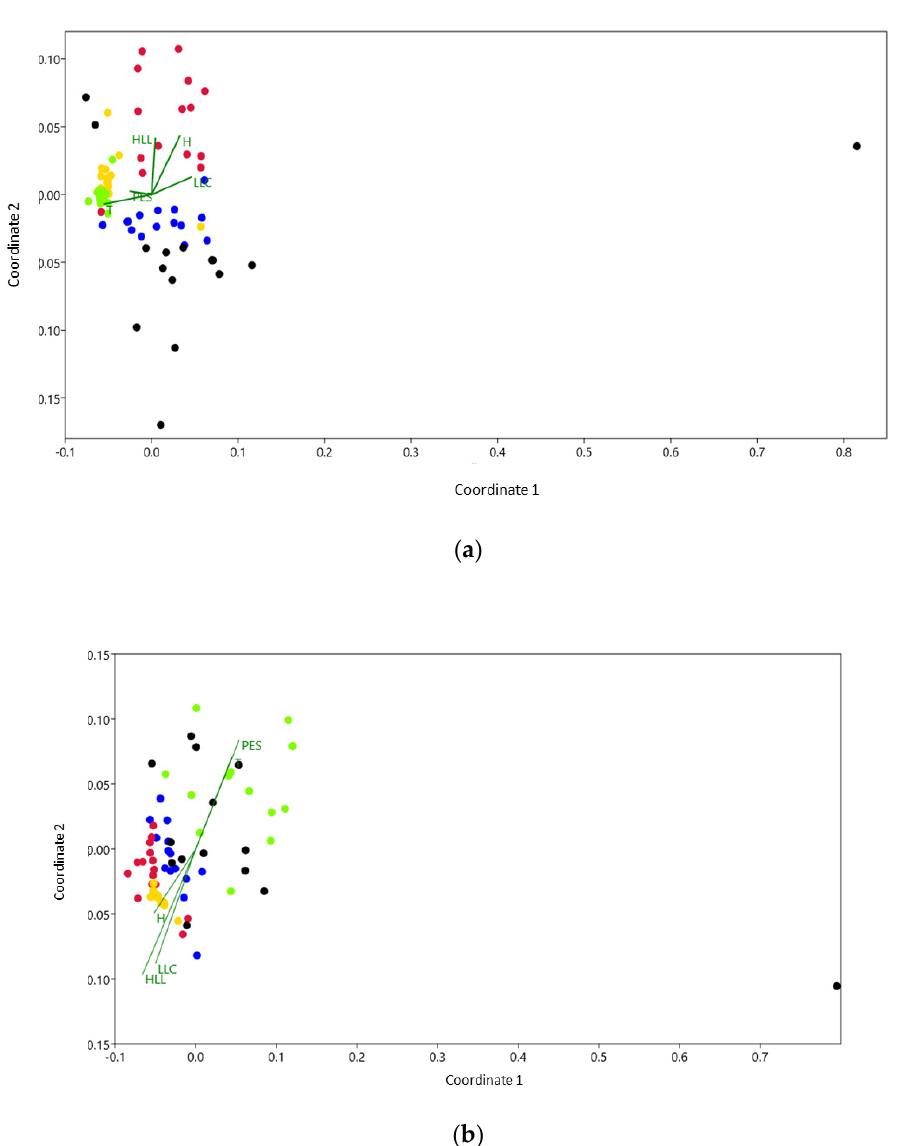
Figure 4. Non-metric multidimensional scaling (NMDS) using Bray–Curtis similarity; 5 environmental variables: ( a ) high-level diversity richness (HLDr) assemblages grouped in accordance with the ecosystems; ( b ) high-level functionality (HLF) assemblages grouped in accordance with the ecosystems. Legend: Ecosystems: PF (Primary forest) as blue, SF (Secondary forest succession with 15 years of regeneration) as red, IF (Incipient secondary succession forest with five years of regeneration) as black, AF (Agroforestry cocoa plantations) as yellow, PA (Pasture) as green. Environmental variables: T = Temperature; H = Humidity; PES = Percentage of exposed soil; LLC = Percentage of leaf litter cover; HLL = Height of leaf litter (cm).